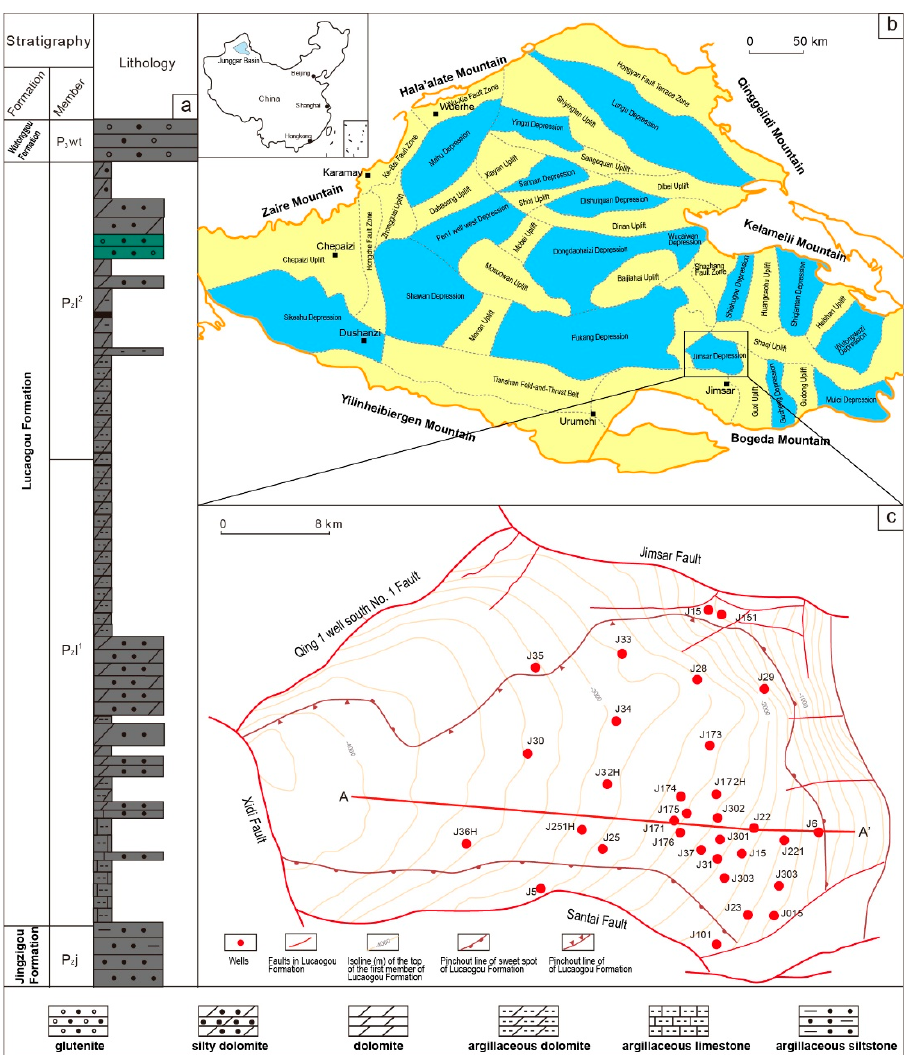
Figure 1. Overview of the petroleum geology of the Jimsar Depression. ( a ) The lithology column of Lucaogou Formation; ( b ) The location of Jimsar Depression in the Junggar Basin; ( c ) Detailed structural map of the Jimsar Depression.